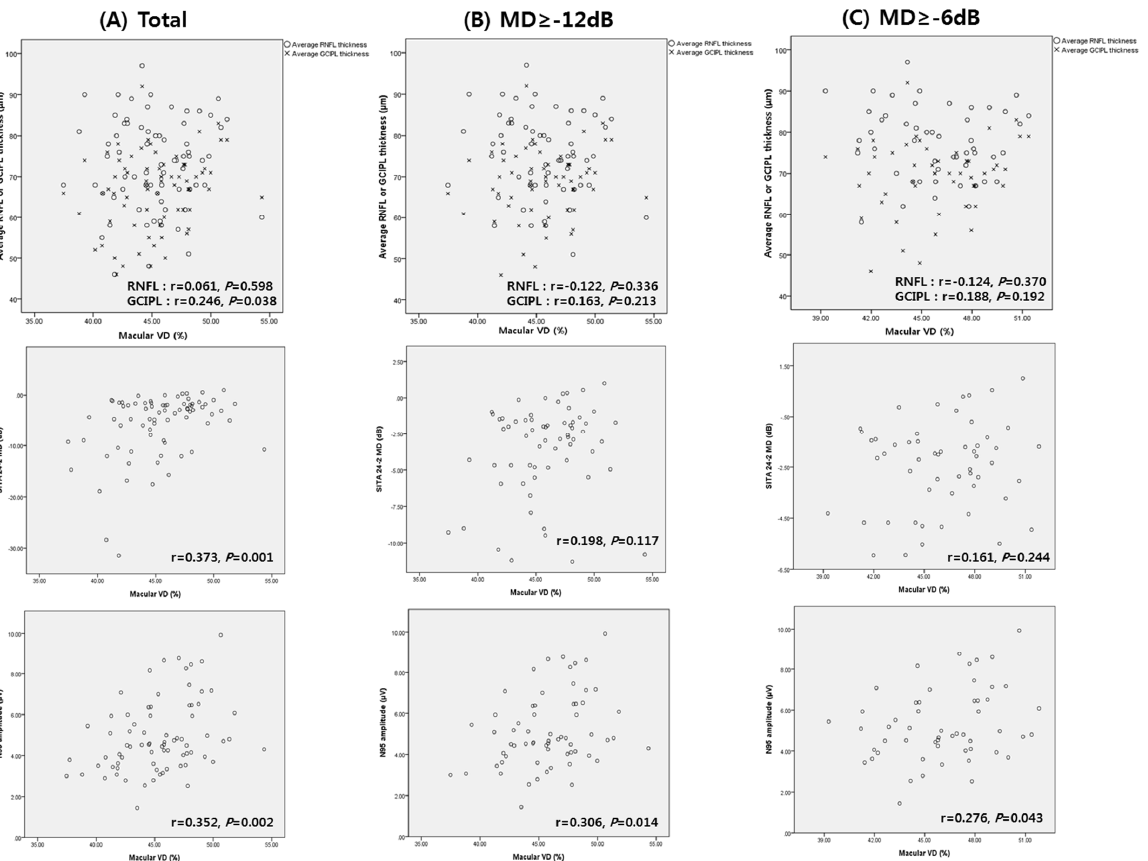
Figure 1. Scatter plots showing associations between macular vessel density (VD), average retinal nerve fiber layer (RNFL) thickness, average ganglion cell layer/inner plexiform layer (GCIPL) thickness, mean deviation (MD) of SITA 24-2, and N95 amplitude of pattern electroretinogram (PERG) from ( A ) total subjects, ( B ) mild to moderate glaucoma, and ( C ) mild glaucoma. Figure 2 shows the distribution of macular VD, RNFL and GCIPL thickness, according to N95 amplitude in mild glaucoma (MD ≥ − 6 dB). Linear R 2 was the lowest for RNFL thickness (linear R 2 = 0.007). Linear R 2 of macular VD was higher than that of GCIPL thick- ness (linear R 2 = 0.076 and 0.065, respectively). In short, the association between N95 am- plitude and macular VD showed the greatest linearity, compared to that of N95 with GCIPL or RNFL.